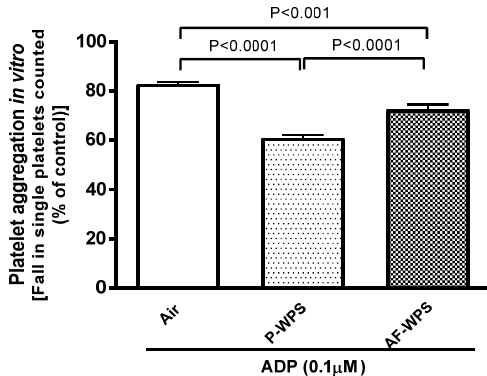
Figure 3. Effects of plain water-pipe smoke (P-WPS) or apple-flavoured (AF)-WPS on platelet aggregation in vitro. In vitro platelet aggregation in whole blood obtained after the addition of adenosine diphosphate (ADP, 0.1 μM ) to whole blood collected from mice at the end of 1 mo exposure period to either air or P-WPS or AF-WPS. Data are mean ± SEM (n = 5); one-way ANOVA followed by Holm–Sidak’s multiple comparison test.